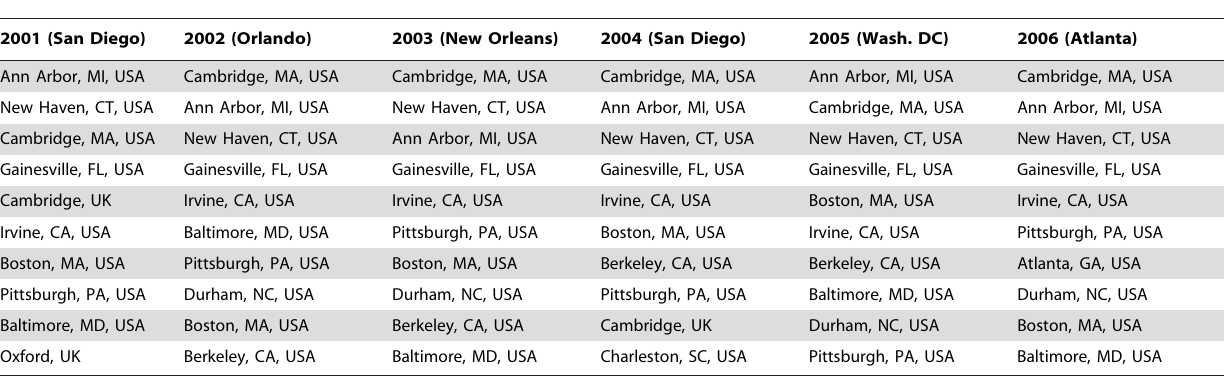
Table 2. Top 10 cities for per-capita SFN representation between 2001 and 2006.